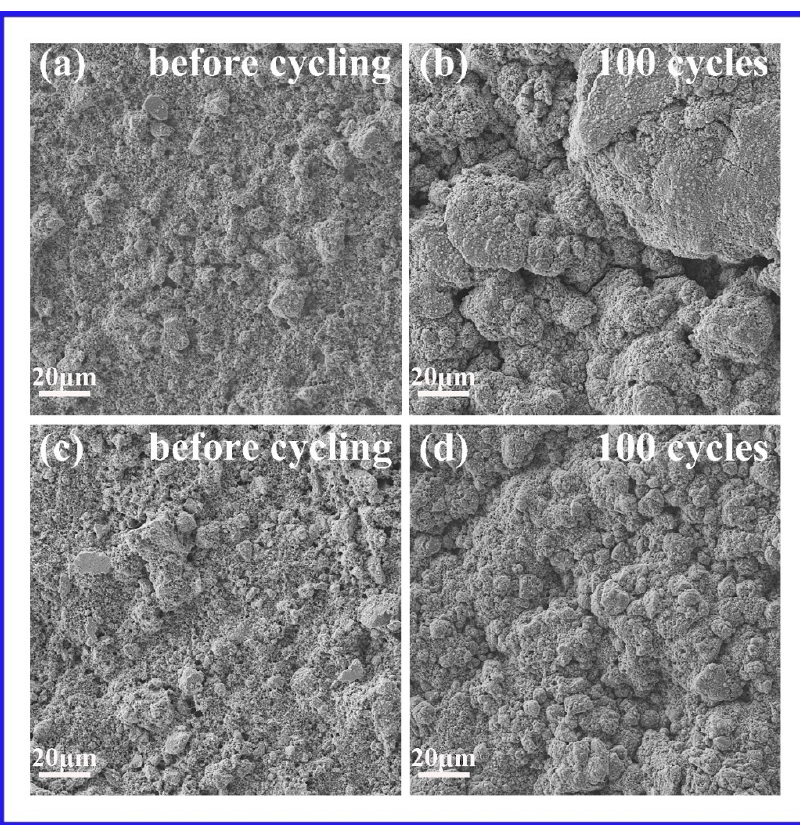
Figure 4. SEM surface morphological evolution of ( a , b ) the MgH 2 –TiO 2 –EG-10 h electrode and ( c , d ) the MgH 2 –TiO 2 –EG-20 h electrode.